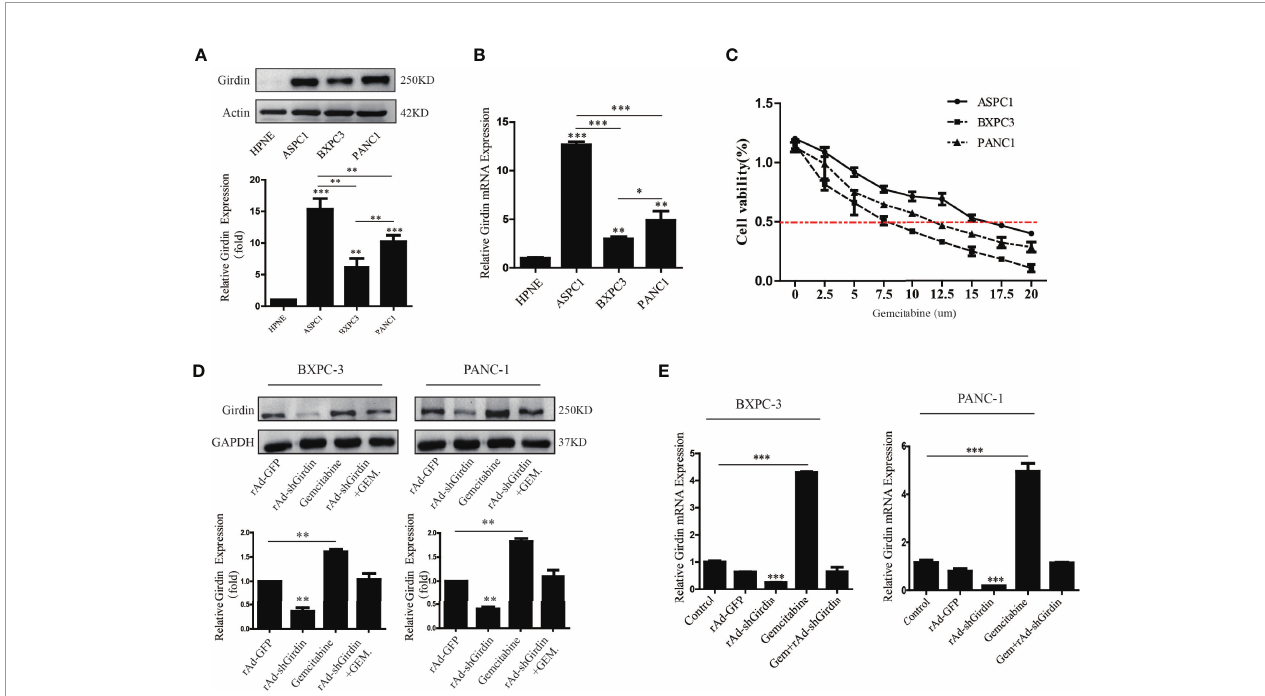
FIGURE 2 | Girdin expression is positively correlated with gemcitabine chemosensitivity in pancreatic cancers. (A, B) Western blots and qRT-PCR were performed to analysis of Girdin protein levels in PC cell lines (Aspc-1, Bxpc-3 and Panc-1) infected with rAd-shGirdin. Bars represent the SEM. (C) The optimal concentration of gemcitabine in different pancreatic cancer cell lines was clari fi ed by MTT assay. (D, E) Western blots and qRT-PCR were performed to evaluate the variation of Girdin level after stimulate with gemcitabine. The empty rAd-GFP vector was constructed as an experimental control. The data are representative of three independent experiments and are expressed as means ± SEM; *P < 0.05, **P < 0.01, ***P <